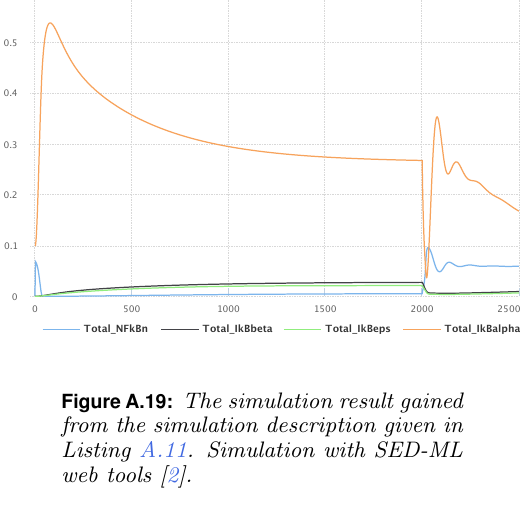
Figure A.20: Simulation with tellurium